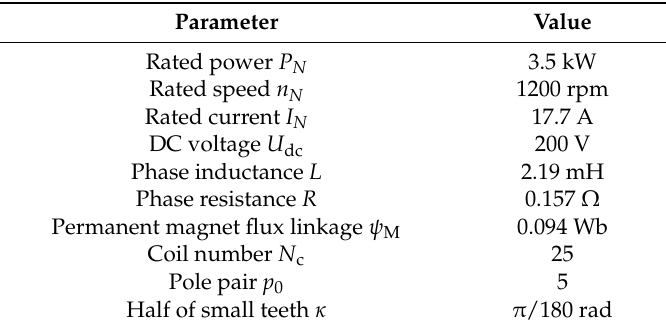
Figure 3. The diagram of stator windings: ( a ) The star graph of fundamental EMF; ( b ) The phase separation. Table 1. The parameters of DRPMSM.